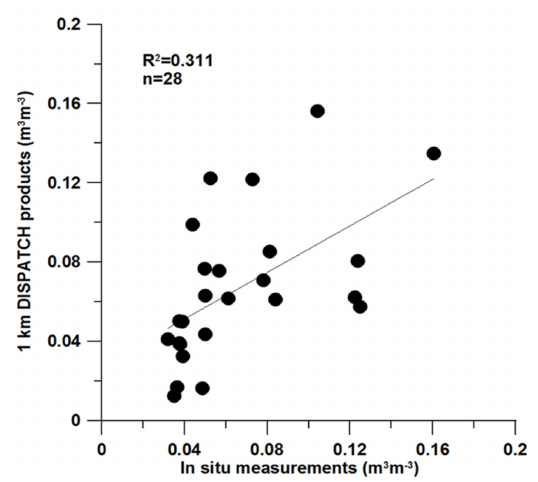
Figure 3. Evaluation of SMOS products (1 km DISPATCH) against the in situ measurements.